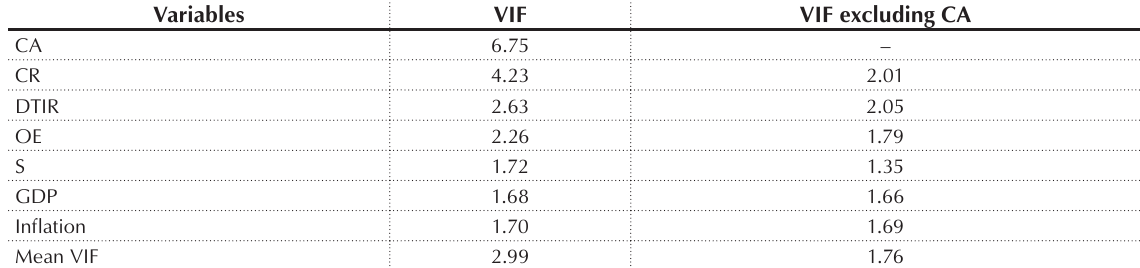
Table 4. (cid:115)(cid:258)(cid:396)(cid:349)(cid:258)(cid:374)(cid:272)(cid:286)(cid:3)(cid:349)(cid:374)(cid:327)(cid:258)(cid:415)(cid:381)(cid:374)(cid:3)(cid:296)(cid:258)(cid:272)(cid:410)(cid:381)(cid:396)